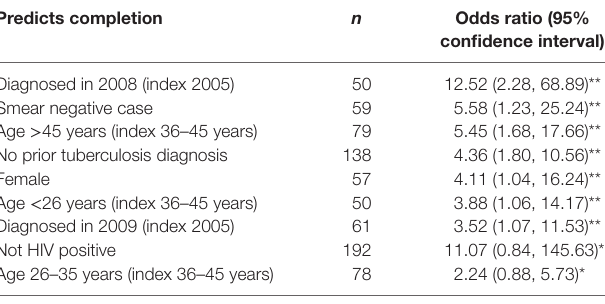
TaBle 6 | Model predicting treatment completion: cDs san luis cases ( R 2 = 0.2082, n = 194). Predicts completion